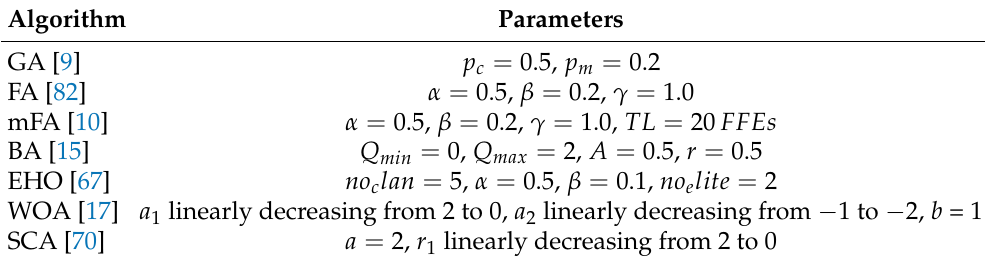
Table 8. Control parameters’ setup for metaheuristics included in